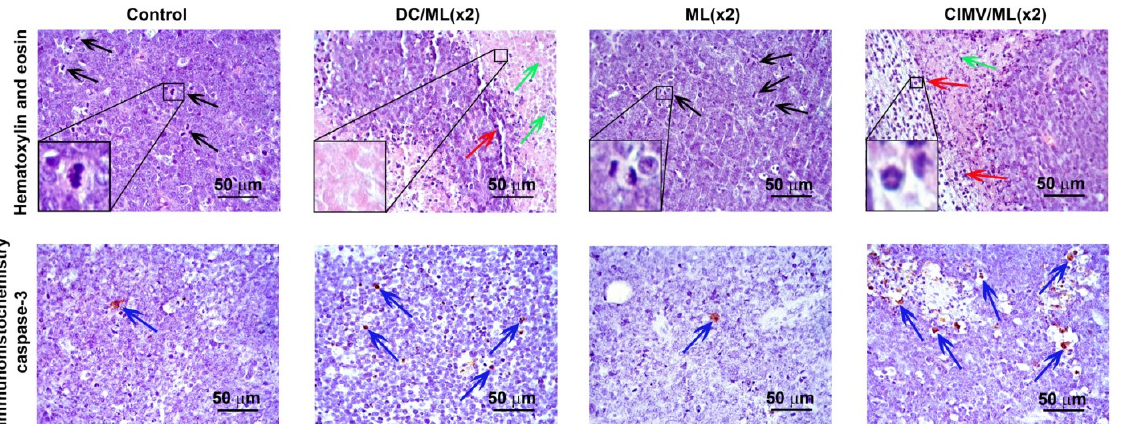
Figure 4. Vaccines inhibit mitotic activity and induce apoptosis in RLS 40 lymphosarcoma tissue. Representative histological images of the tumor sections. Hematoxylin and eosin staining (upper panel) and immunohistochemical staining with anti-caspase-3 primary antibodies (bottom panel). Black arrows indicate mitosis events. Red arrows indicate inflammatory infiltration. Green arrows indicate necrotic changes. Blue arrows indicate caspase-3-positive cells. Black boxes indicate typical examples of mitosis, necrosis, and granulocyte. Original magnification ×400. Table 3. Morphometry of RLS 40 lymphosarcoma tissue of mice without treatment (control) and after vaccine administration.